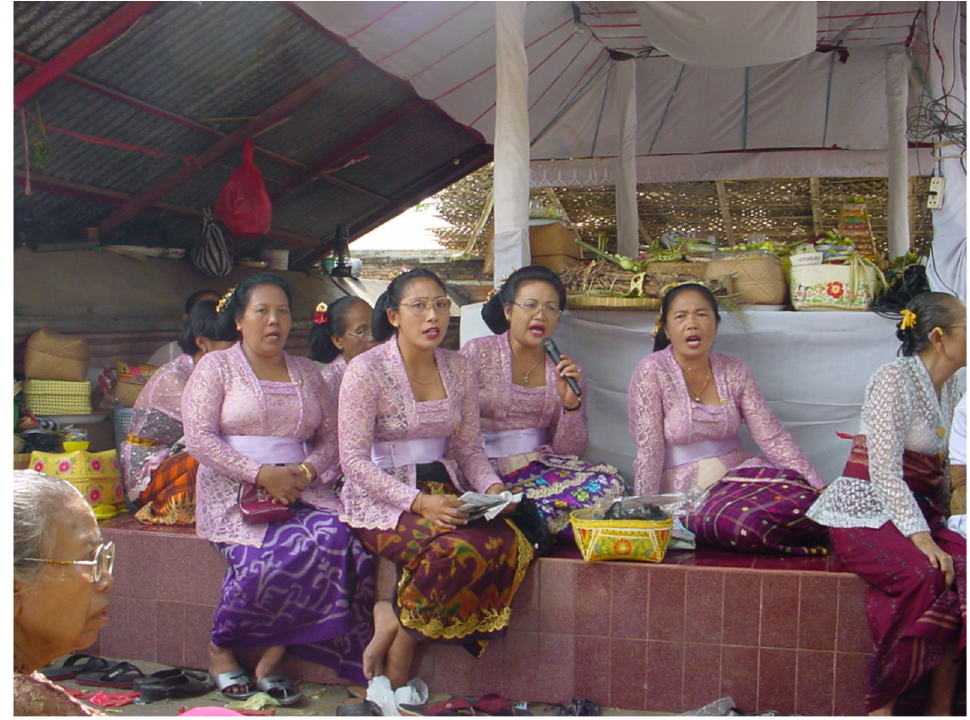
Figure 1. Balinese women kidung singers in the kemaliq, Lingsar, 2001. Photo by author. The top é ng performance disappeared in the 1990s and has never been held again; the explanation I received was that the program was too full. One new dance, however, Rejang D é wa was instead added to the program. Featuring eight women dressed in yellow and white wearing distinctive head-dresses, Rejang D é wa was a modern, ritual dance with set choreography and a favorite of Hindu reformers that the PHDI imposed upon